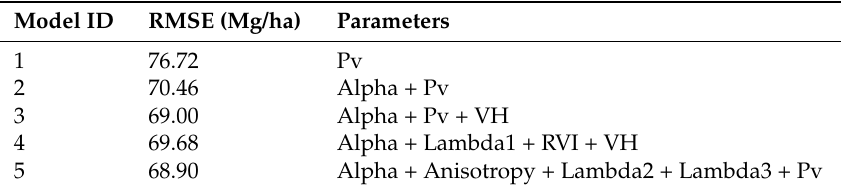
Table 3. RMSE of best models of size 1 to 5.